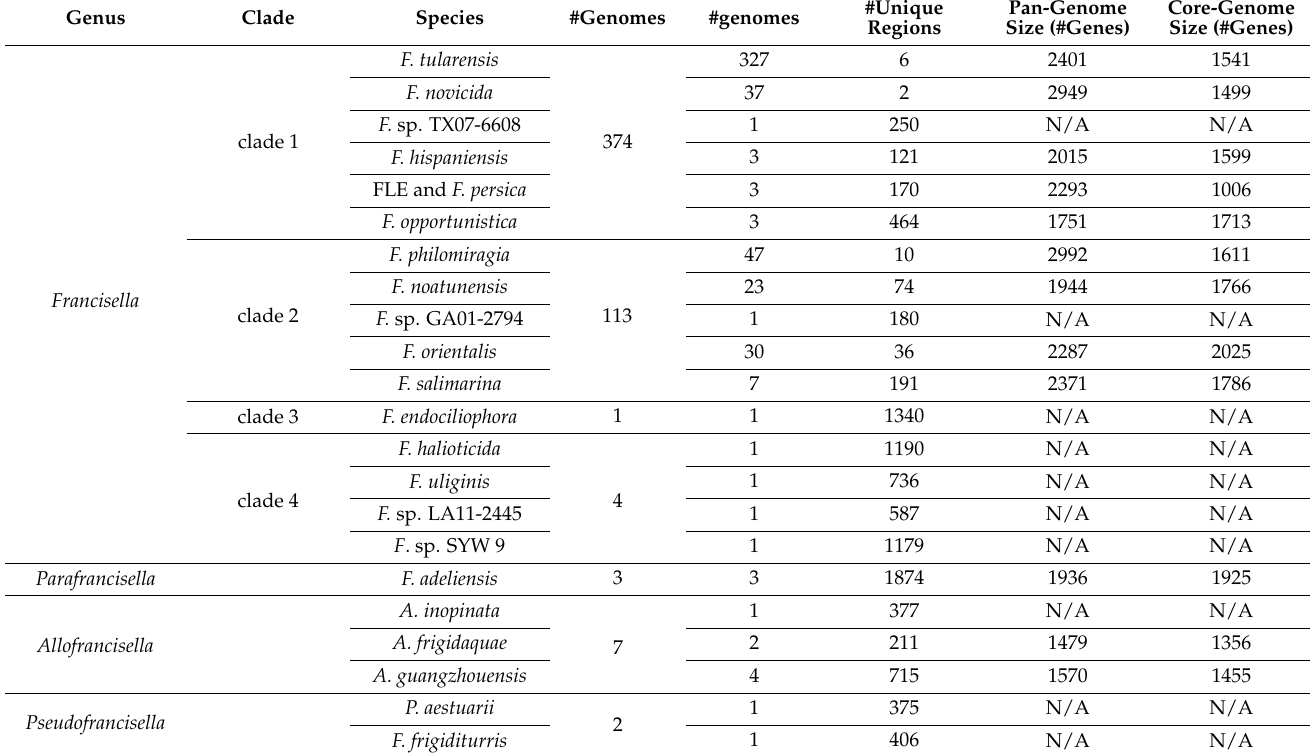
Table 2. Overview of genome distribution within clades and species, including detailed information about the number of unique regions for each species and pan/core genome size.